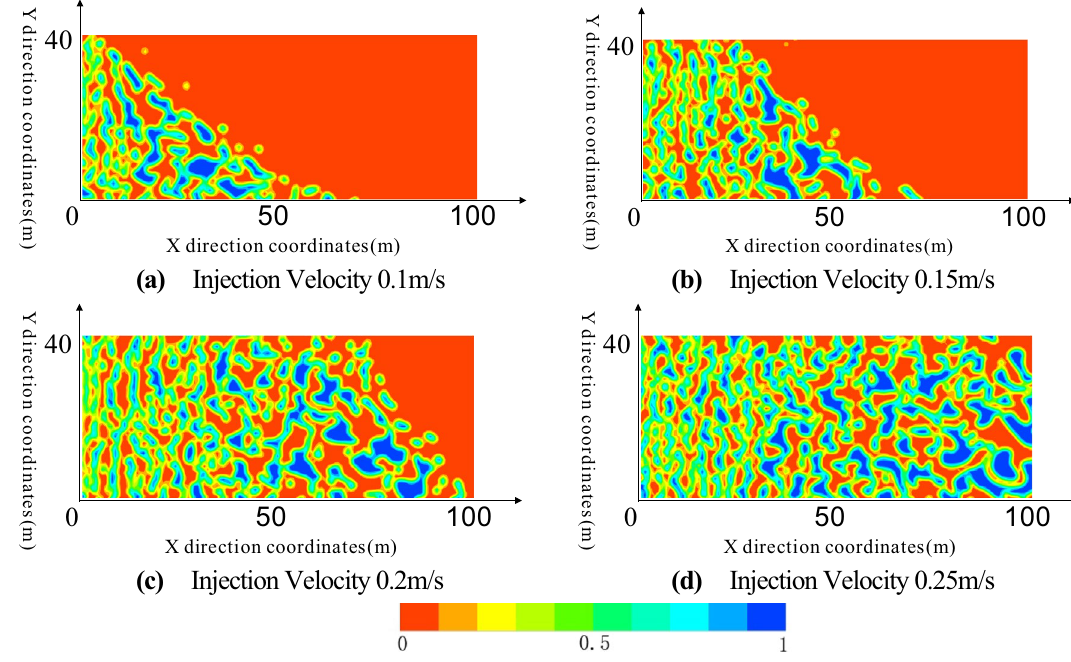
Fig. 11 Volume fractions of the SPFL at different injection